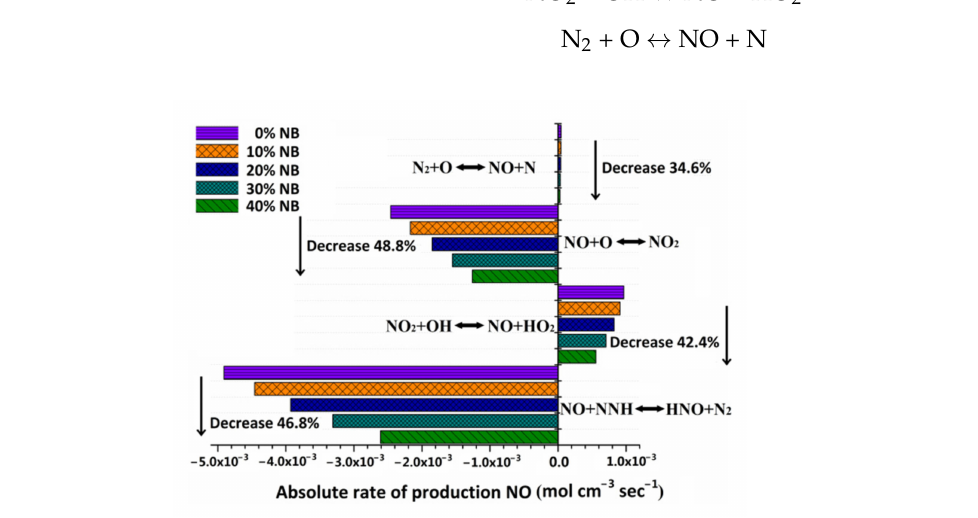
Figure 14. Effect of n-butanol mixing ratio on NO formation rate.